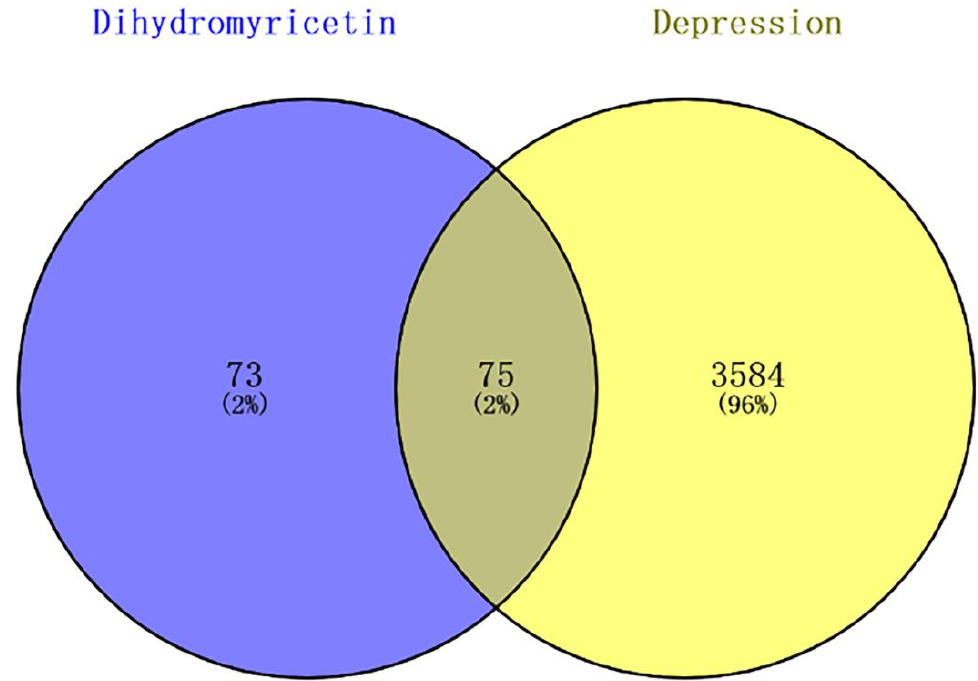
Figure 3. The intersection of Dihydromyricetin targets and depression targets.